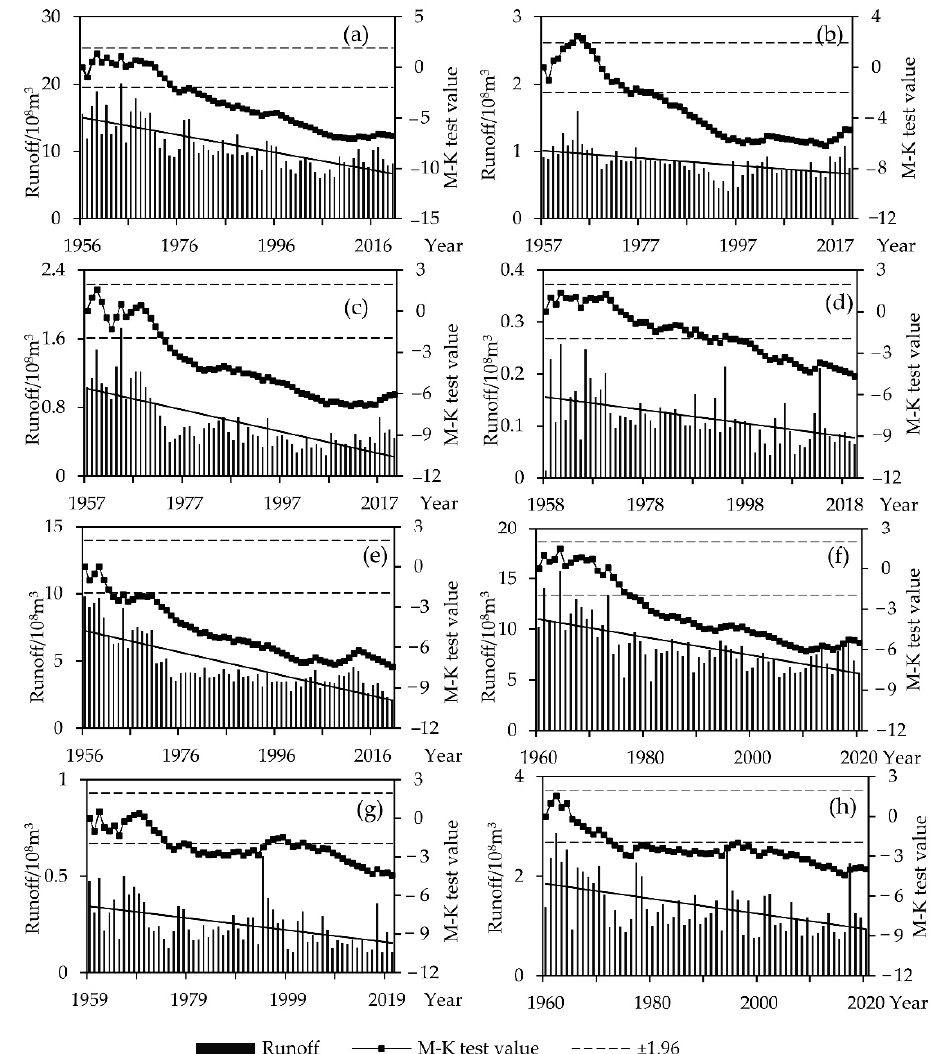
Figure 2. Variations in runoff and M–K test values in the Wuding River basin. ( a ) Baijianchuan gauging station; ( b ) Hanjiamao gauging station; ( c ) Hengshan gauging station; ( d ) Dianshi gauging station; ( e ) Zhaoshiyao gauging station; ( f ) Dingjiagou gauging station; ( g ) Lijiahe gauging station; ( h ) Suide gauging station. Table 1. Runoff values and variation trends (M–K test values) at the eight gauging stations in the Wuding River basin.